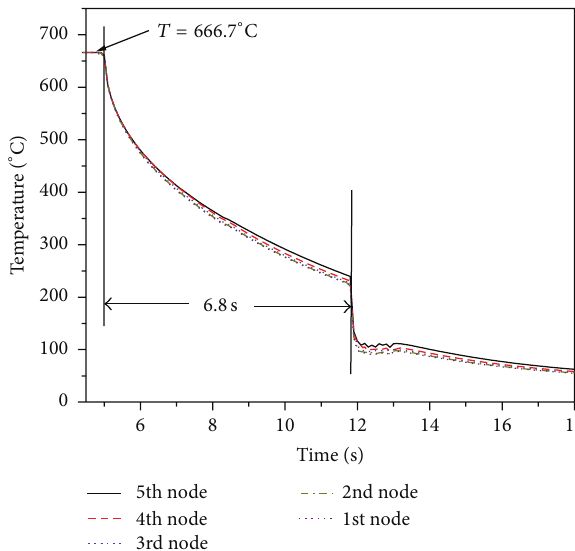
Figure 12: Transient temperature of different axial nodes of outer